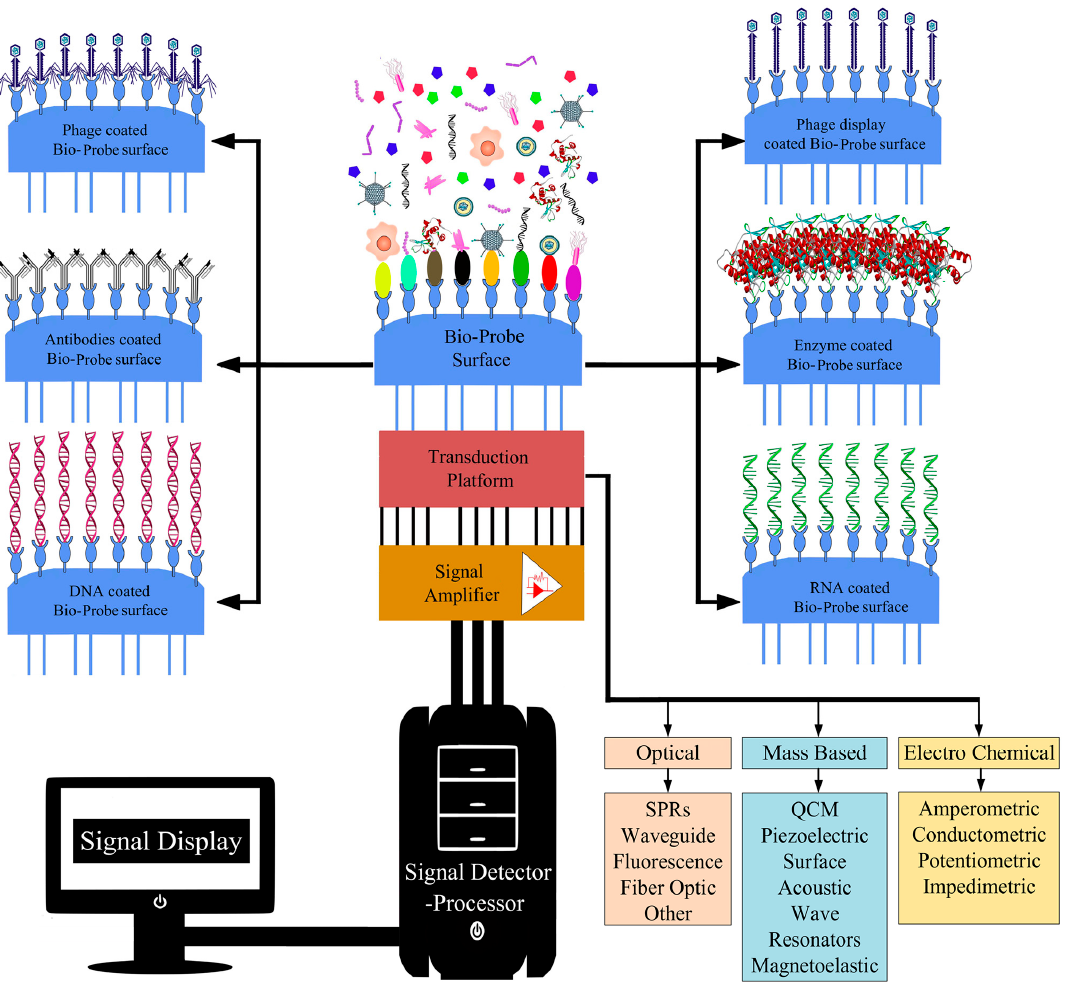
Figure 3. The schematic diagram shows the types of bio-probes and transducer in the biosensor. The figure is shown how the device works to detect